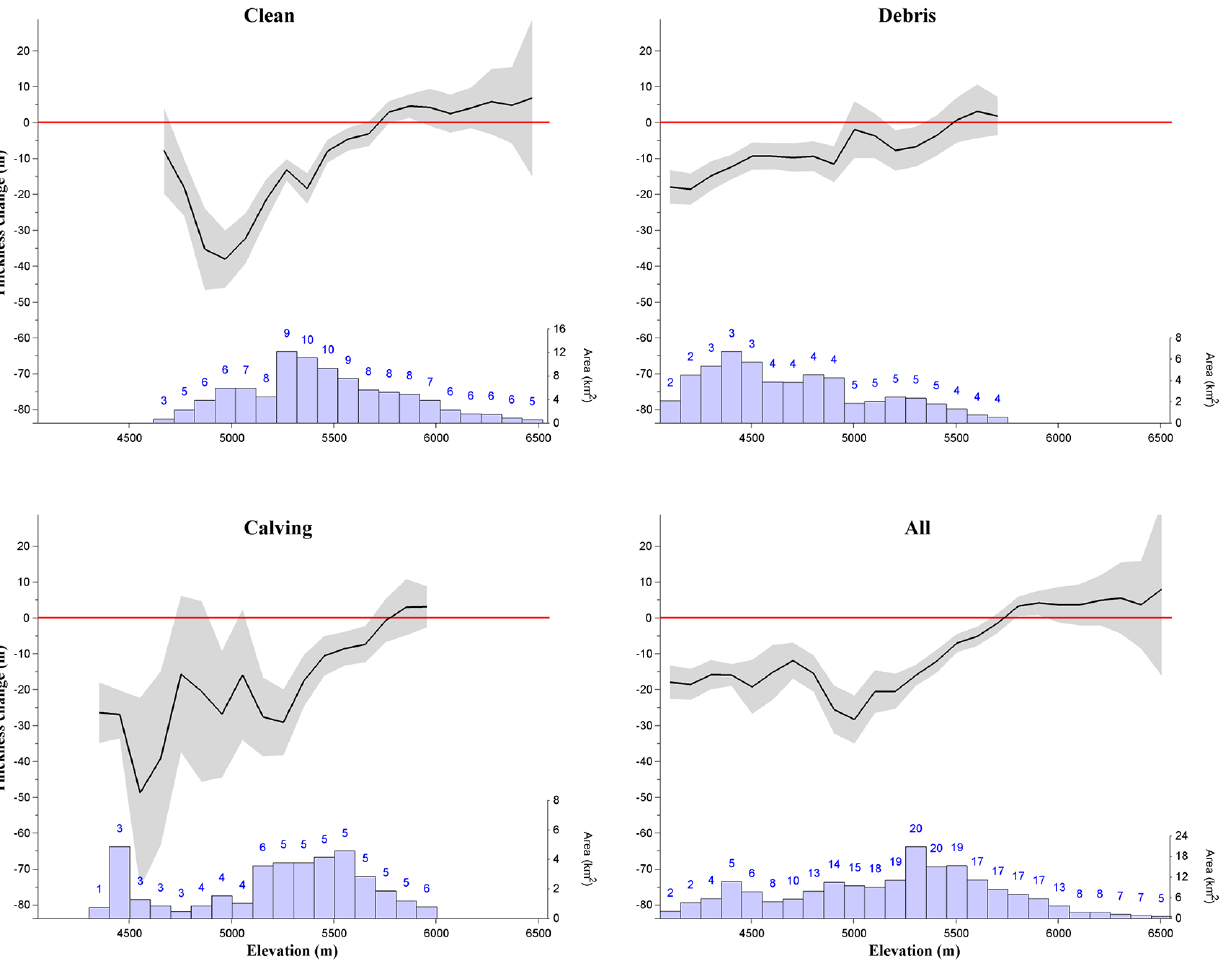
Figure 4. Ice thickness change profiles for clean-ice, debris-covered, calving, and all glaciers (rates of change can be obtained by dividing values on the vertical axis by 32 years). Thickness change pixels are separated into 100m bands; black lines are the mean, and the grey √ n z , where σ z is the standard deviation of elevation change for shaded regions represent the standard error of the mean estimated as σ z / each band and n z is calculated using Eq. (5). The glacier area (km 2 ) contained in each band is indicated by the blue histogram bars, and the number of glaciers contributing to each elevation band is shown by the blue number above each bin. Note that the histogram bars do not include extrapolated